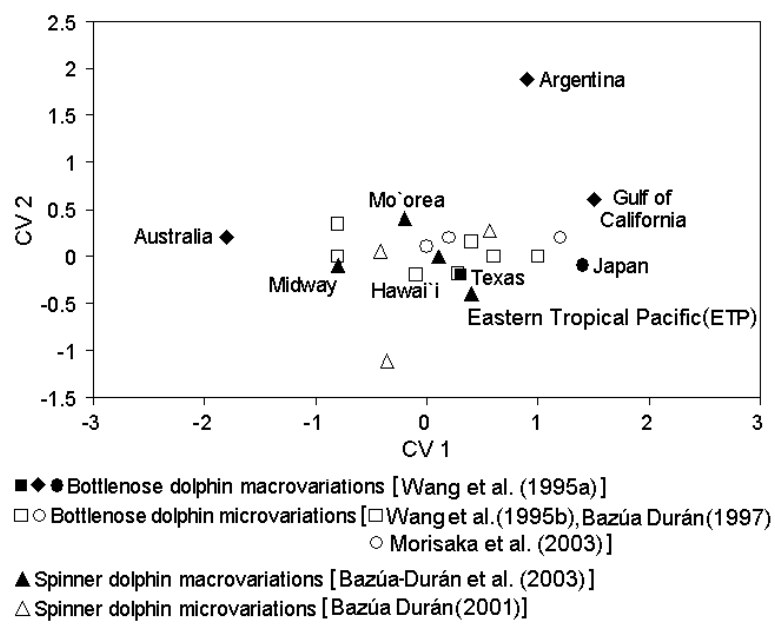
Fig. 3 – Means of the first 2 canonical variates (CV) for the between-group pairwise comparison of Bottlenose and Spinner Dolphin whistles looking at microgeographic and macrogeographic